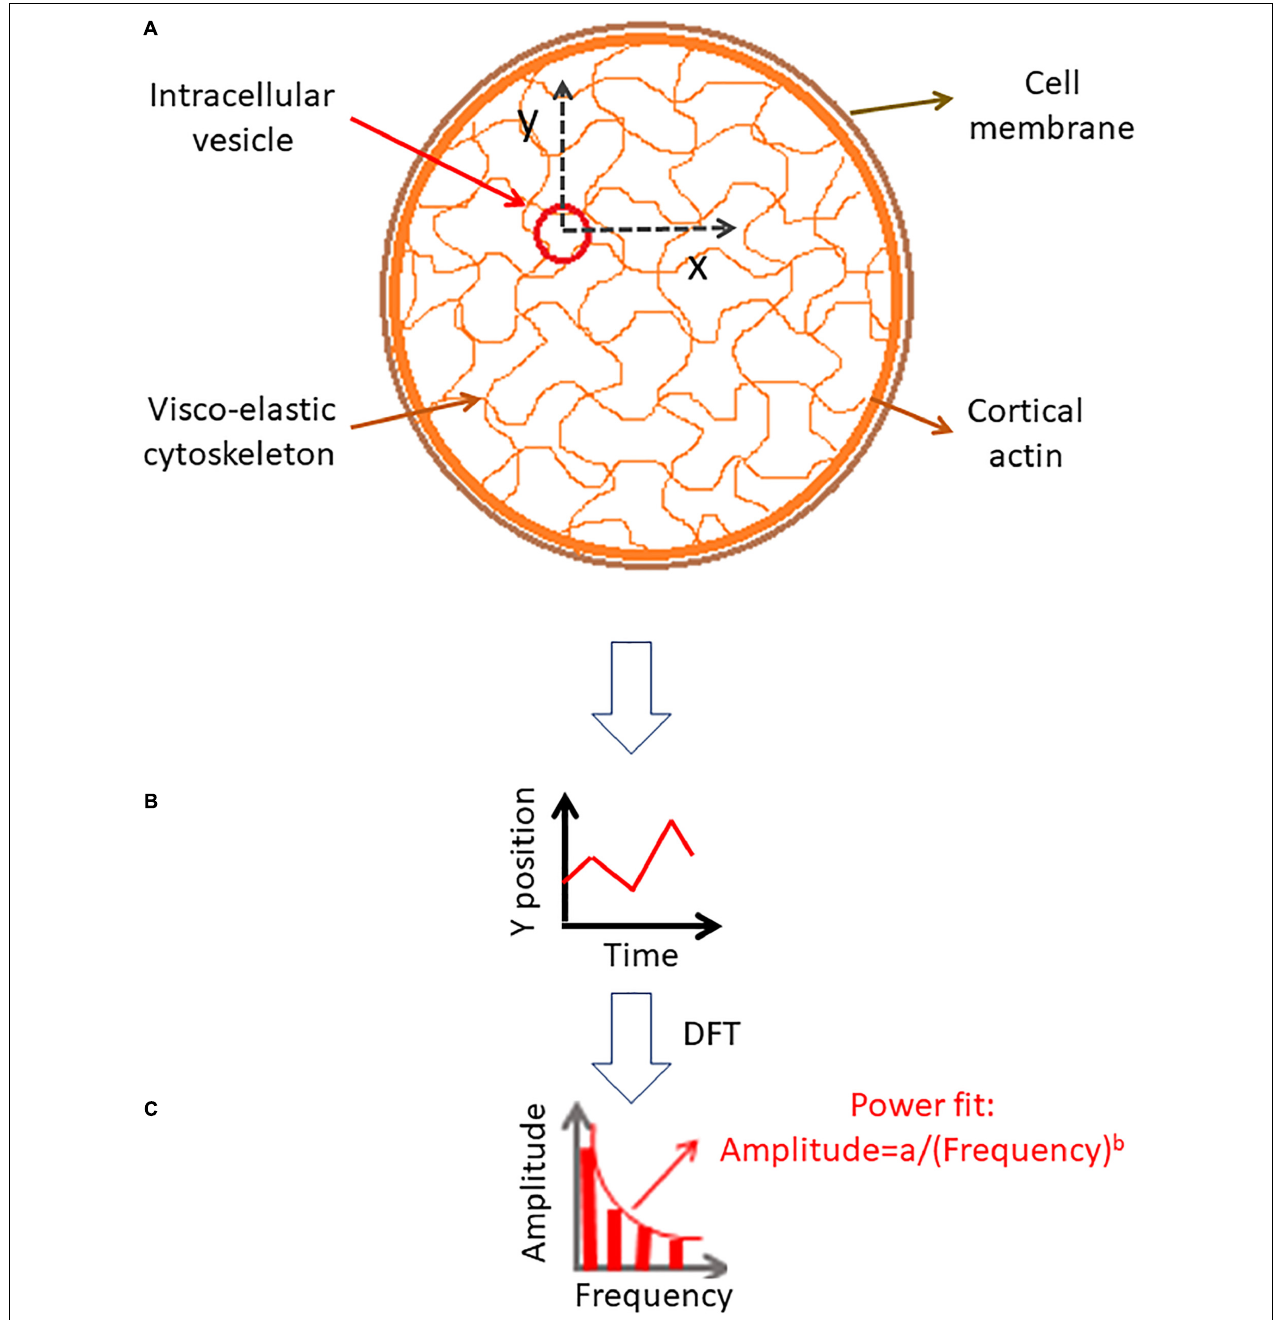
FIGURE 1 | Analysis of intracellular particle motion embedded inside the cytoskeletal mesh. (A) Particle motion in x and y dimensions. (B) Demonstration of the particle position change in time in one dimension. (C) Discrete Fourier Transform (DFT) of the particle position serial results [as shown in panel (B)